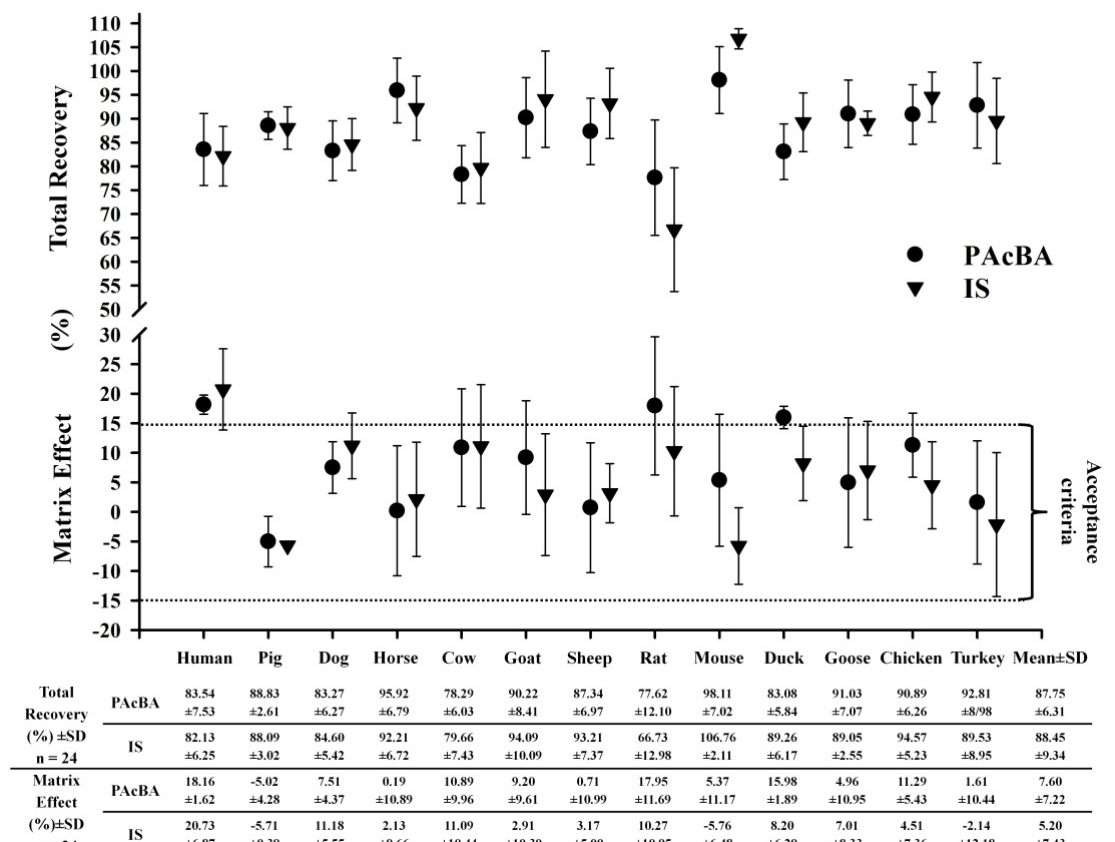
Figure 1. Matrix effect and total recovery of 4-acetamidobenzoic acid (PAcBA) and internal standard (IS) in humans and twelve animal species. Each point represents the mean value ( ± SD) calculated from six replicates of four quality control points for each matrix and reference sample ( n = 24 per point).